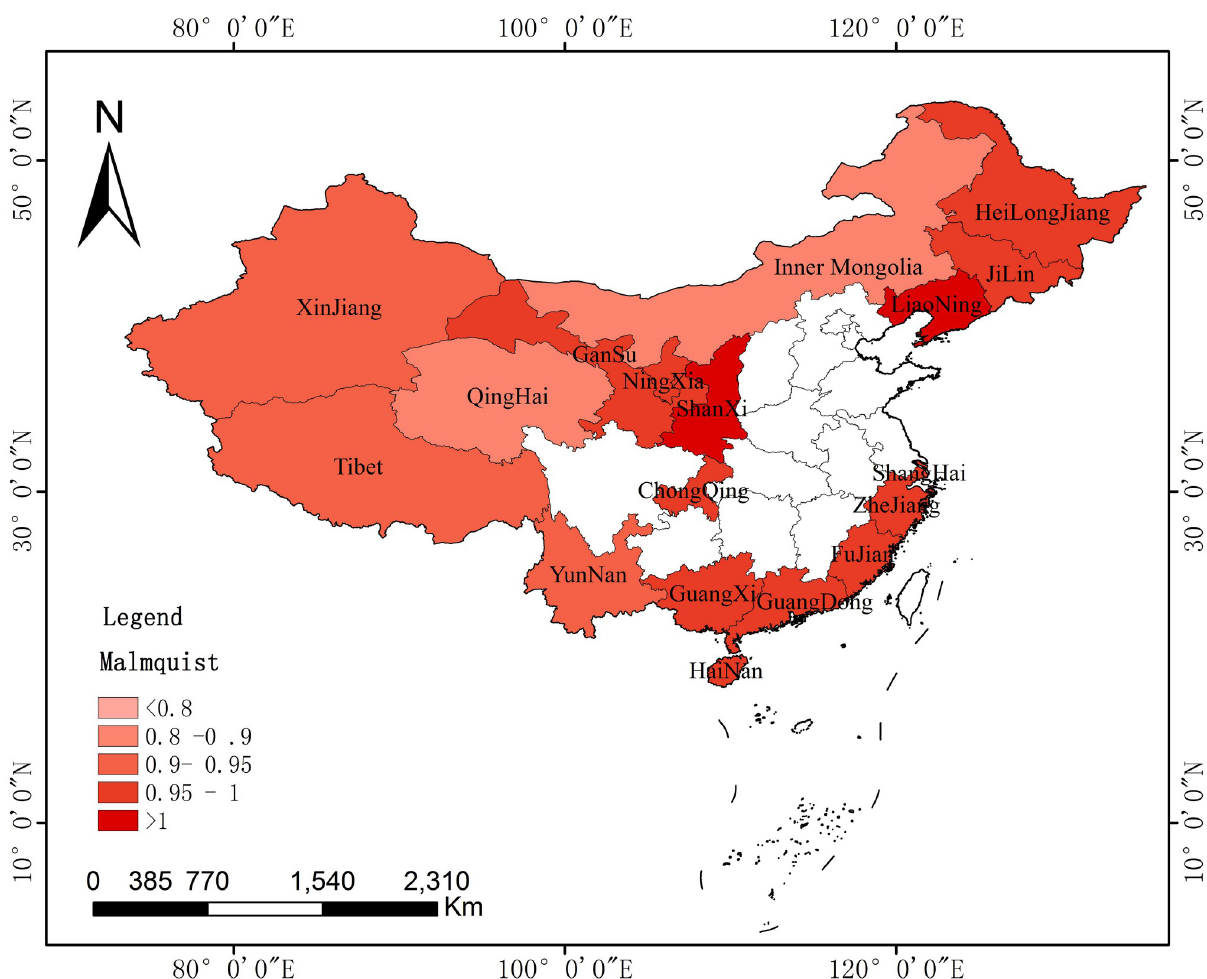
Fig 6. Spatial distributions of the Malmquist index of key provinces along the B&R in 2015.